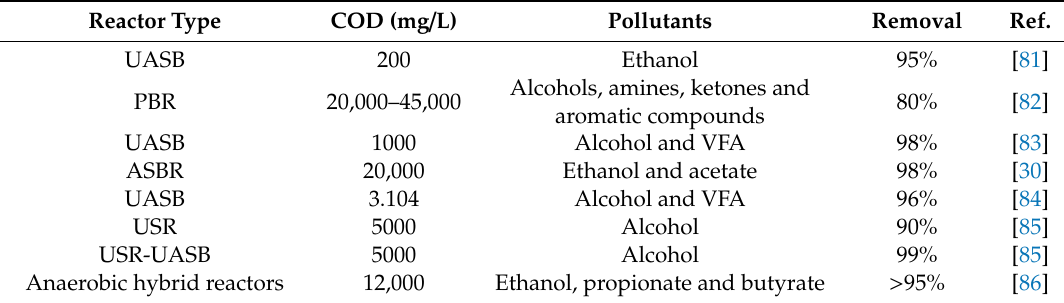
Reduction in COD content caused by the removal of contaminants that present in GTL-processed